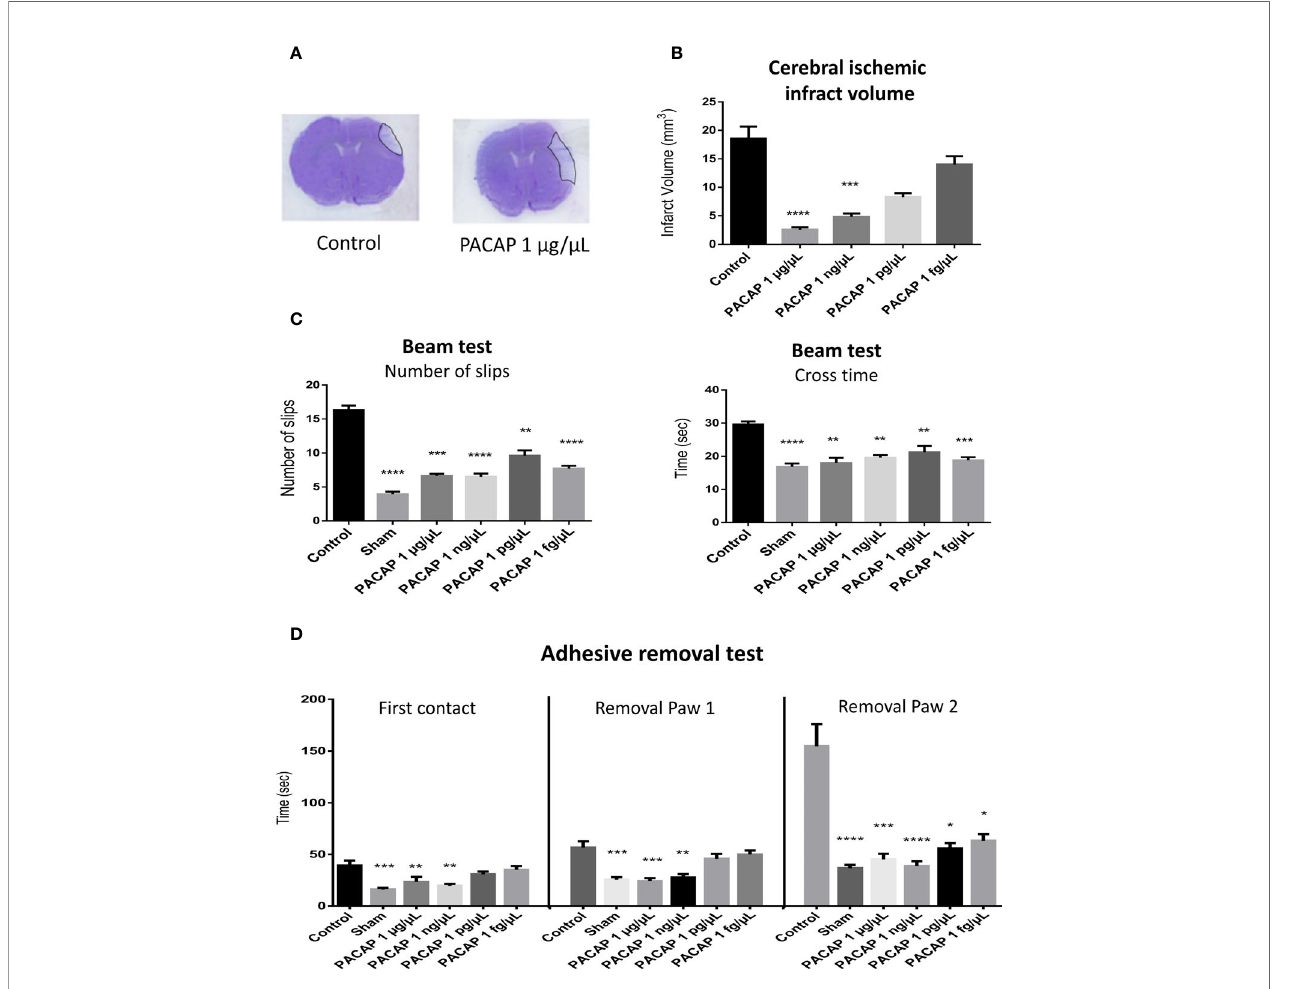
FIGURE 2 | Effects on the infarct volume and functional recovery, 2 days after stroke, of a single intranasal (IN) administration of decreasing concentrations of PACAP provided 1 h after pMCAO. Male C57BL6 mice were treated with a saline solution (NaCl 0.9% for control and sham) or with 10 µl of different PACAP concentrations (1 µg/µl, 1 ng/µl, 1 pg/µl, and 1 fg/µl dissolved in NaCl 0.9%). (A) Illustration of the brain infarct zone after NaCl (Control) or PACAP 1 µg/µl IN administration, 48 h after pMCAO. (C) Cerebral ischemic infarct volume (mm 3 ) 48 h after pMCAO. (C) Beam test indicating cross times and number of slips of mice on 9-mm beam. (D) Adhesive removal test with the time taken for fi rst contact and adhesive removal from mice paws 2 days after stroke. PACAP treatment promoted functional recovery and reduced cerebral ischemic lesions in stroke mice. Variations of n ≥ 6 animals per group are reported as S.E.M. (*P < 0.05; **P < 0.01; ***P < 0.001; ****P <